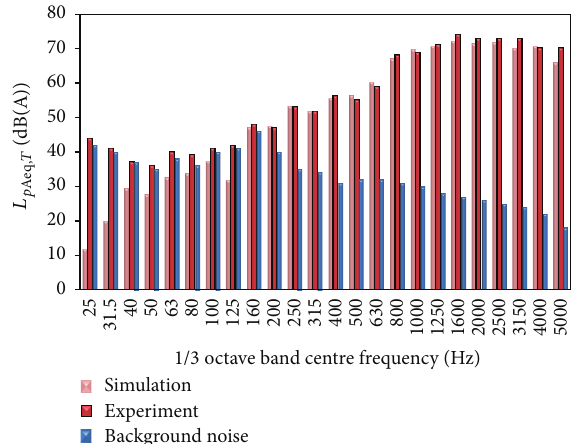
Figure 5: Comparison of simulated and experimental spectra.